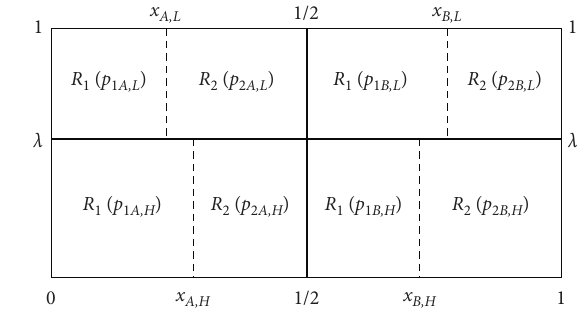
Figure 3: Consumers’ distribution and retailers’ market shares in the IN